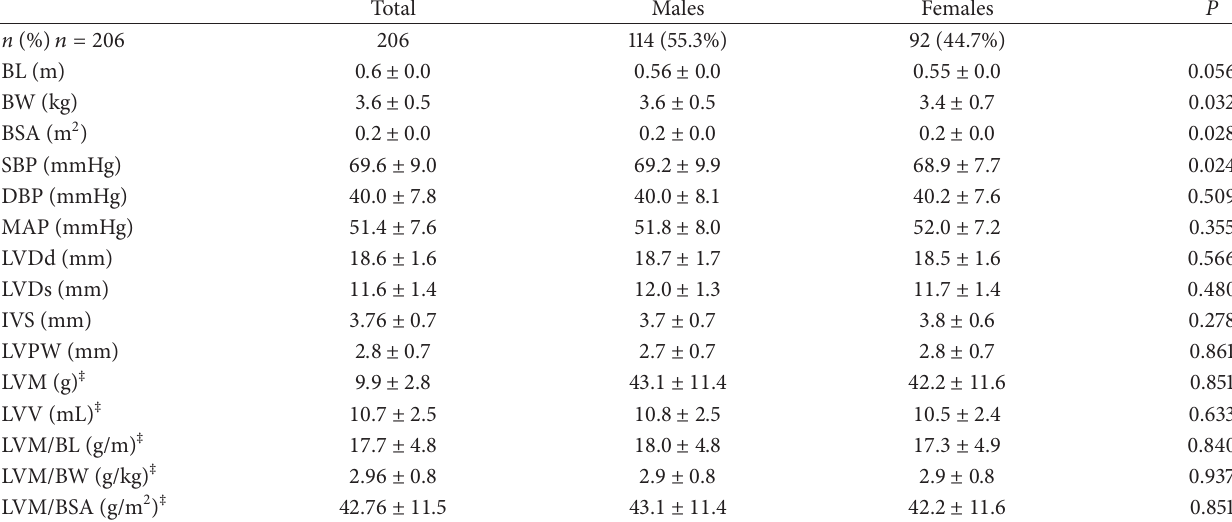
Table 1: Clinical and echocardiographic characteristics of the newborns in regard to